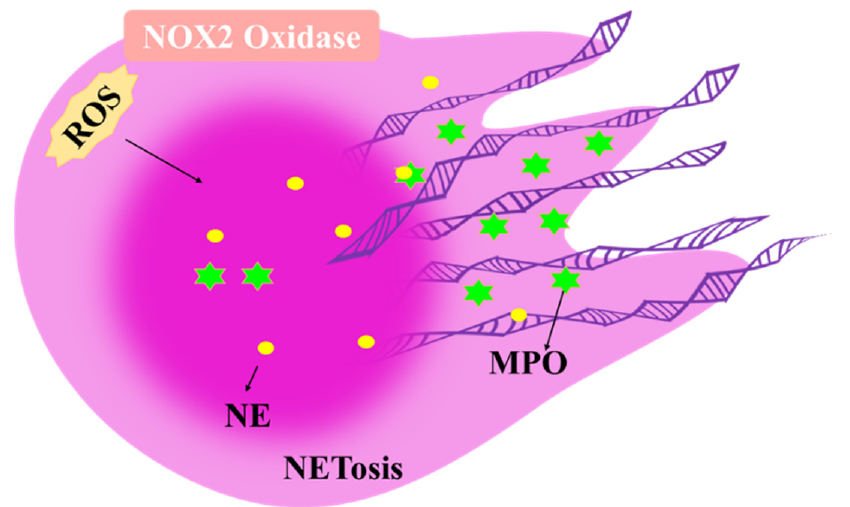
Figure 5. The role of ROS in neutrophils. ROS trigger the translocation of neutrophil elastase (NE) to the nucleus, where myeloperoxidase (MPO) then binds to chromatin and synergistically enhances chromatin deconcentration, leading to cell rupture and NET release.